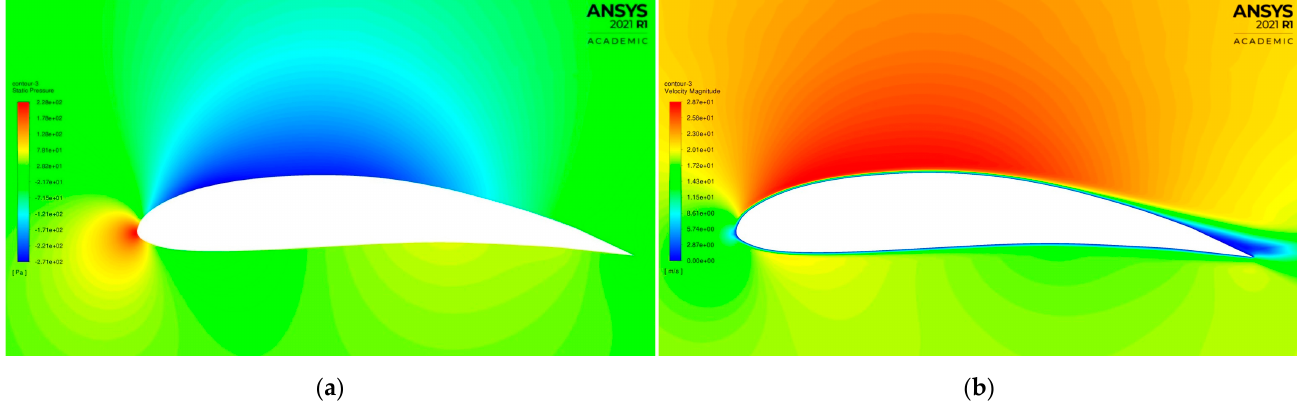
Figure 17. ( a ) Static pressure and ( b ) velocity distribution around NACA 4415 at 8° camber and zero angle of attack . angle of attack.